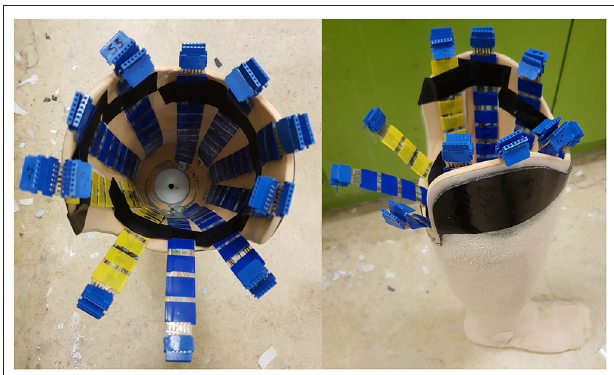
FIGURE 2 | Interior and exterior of a socket in which sensors have been fixed with double-sided adhesive